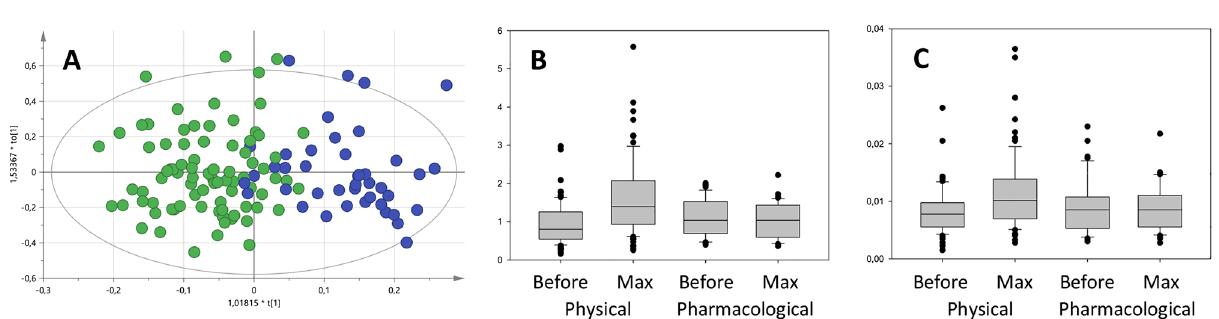
Figure 3. ( A ) corresponds to the OPLS-DA model differentiating exercise stress samples obtained before and at the time of maximum stress (Green dots: before; blue dots: maximum intensity). ( B , C ) correspond to the box plots of the concentrations of lactate and alanine,